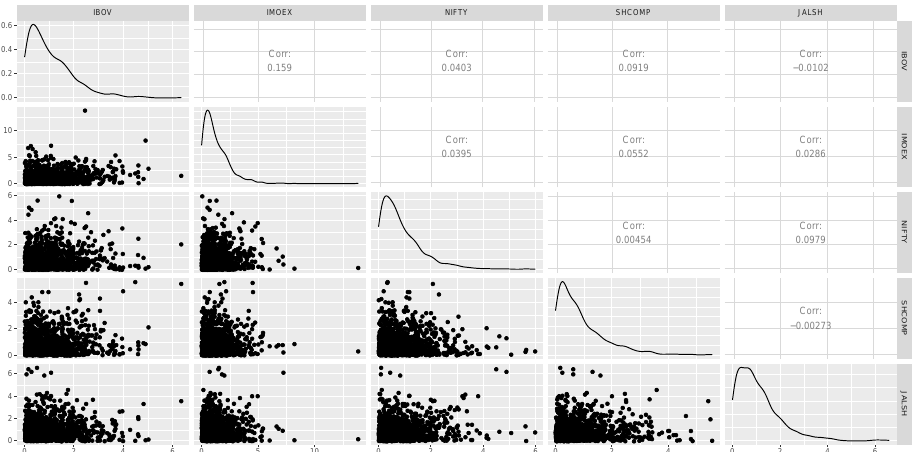
An insightful examination using exploratory plots can be made into the pairwise dependence of the BRICS variables under consideration via a pairwise scatterplot. However, it should be acknowledged that pairwise dependence between variables in the data body does not automatically indicate extremal dependence (Southworth et al. 2020). Figure 6 describes the exploratory scatter plots of the five BRICS stock markets.